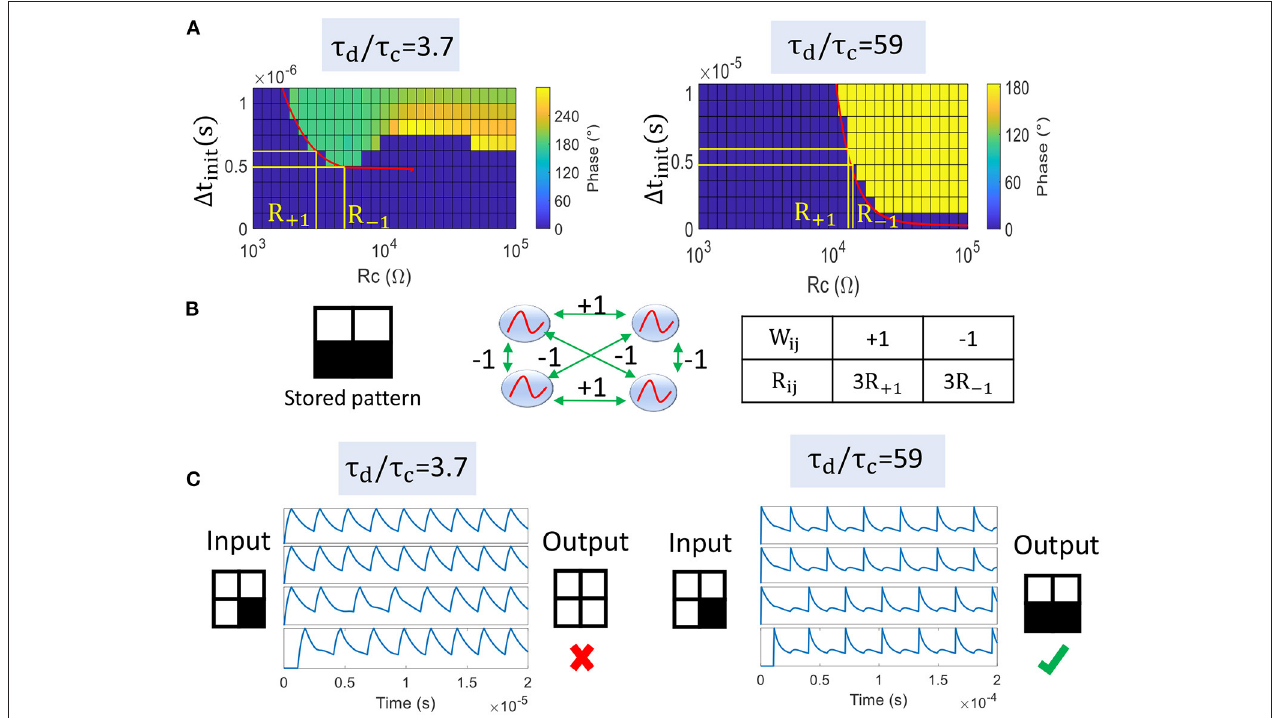
FIGURE 8 | (A) Phase plots showing 1φ out with respect to 1 t init and coupling resistance R C between two oscillators. For τ d /τ c = 3.7, 180 ◦ phase state is not reachable for low 1 t init values. In contrast for τ d /τ c = 59, 180 ◦ phase-locking can occur for any 1 t init value for large R C . The red line is our analytical model ζ ( R C ) and captures well the boundary between phase regions. (B) Four coupled oscillators store a pattern composed of 2 white and 2 black pixels. Positive and negative weights are mapped to 3x R + 1 and 3x R − 1 , respectively. (C) ONN inference for τ d /τ c = 3.7 and τ d /τ c = 59. The first configuration leads to a wrong in-phase relationship for all oscillators. In the latter case, ONN retrieves the correct stored pattern.